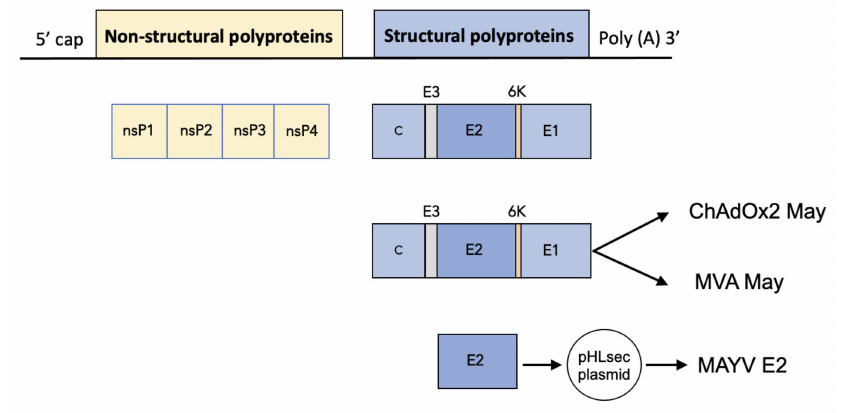
Figure 1. Mayaro virus (MAYV) genome organization and design of viral-vectored May vaccines and recombinant MAYV E2 glycoprotein. On ( top ): Lines represent non-translated regions and boxes represent translated regions, whereas the yellow boxes represent the non-structural proteins and the blue boxes the structural proteins. ( Below ): arrows indicate translated regions that were cloned into the indicated vaccine vectors or the mammalian expression plasmid pHLsec.